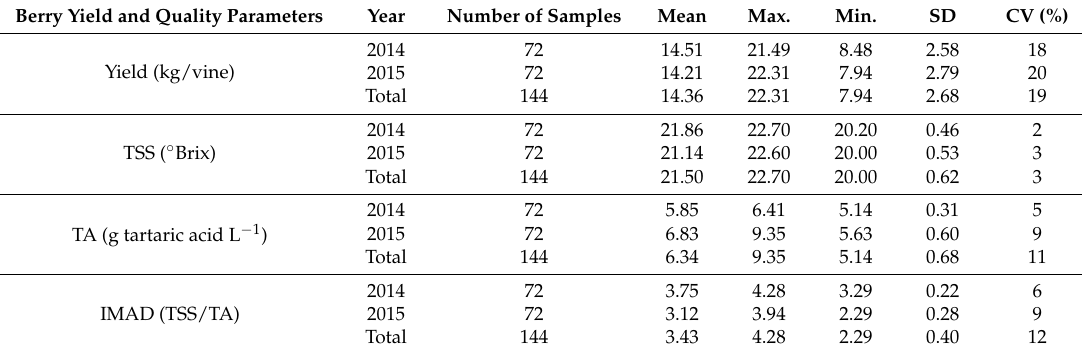
Table 3. Descriptive statistics of the berry yield and quality